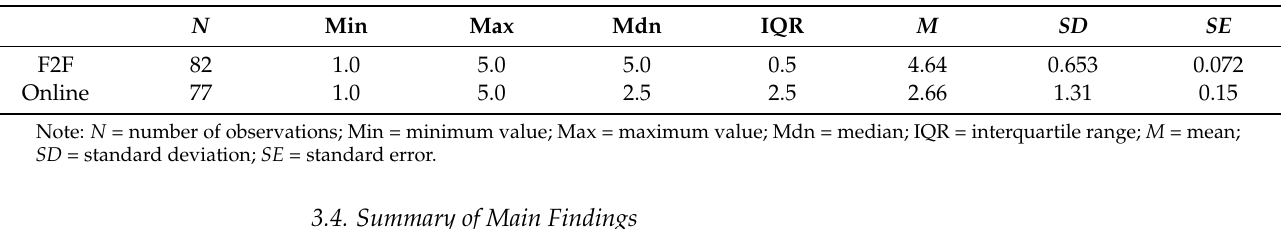
Table 4. Descriptive statistics for the participants’ preferences on modality of delivery.